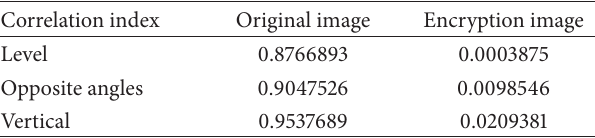
Table 3: The correlation coefficient of the original image and the cipher image